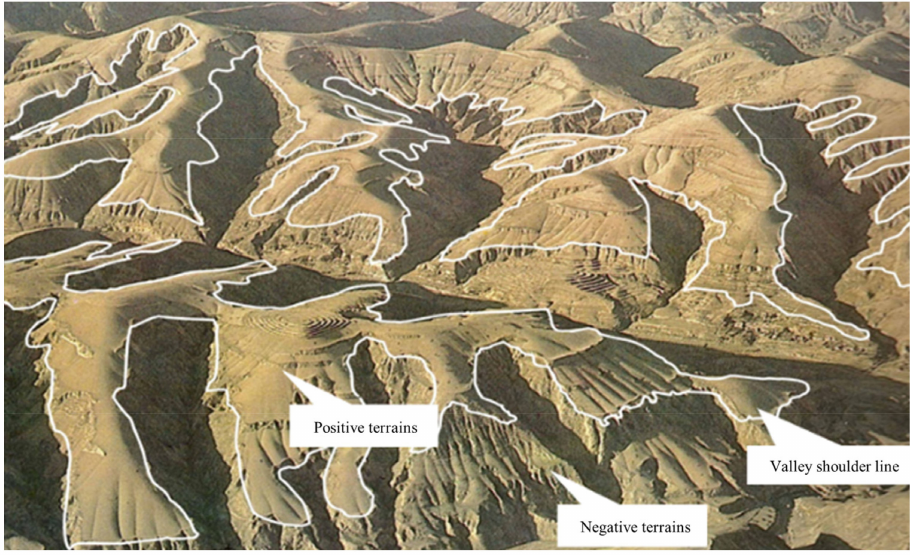
Figure 5. The diagram of positive and negative terrains (this figure is cited from